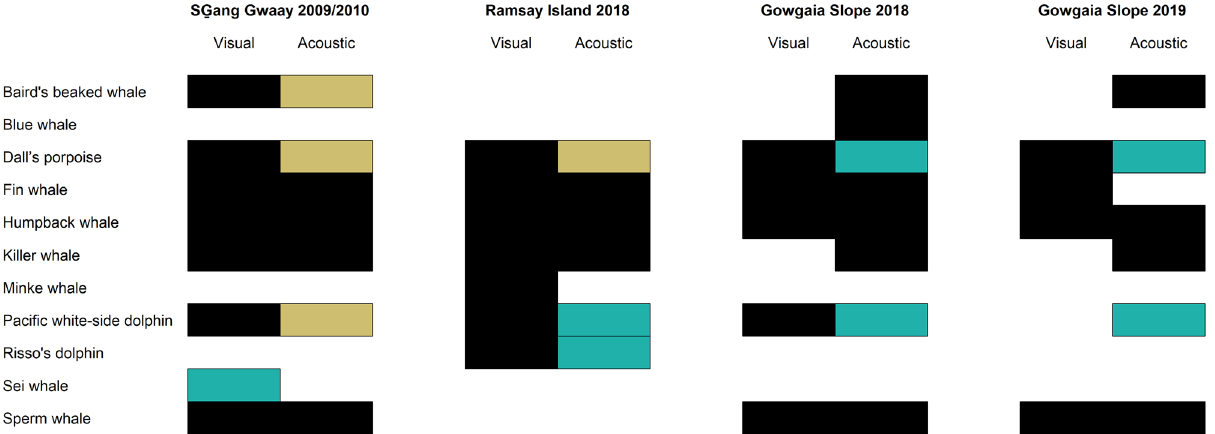
Figure 14. Summary of the visual sightings (black rectangle) from visual surveys (SG ̱ ang Gwaay: July/August 2009 and July 2010; Ramsay Island: August 2018; Gowgaia Slope July 2018 and July 2019) and cetacean acoustic presence (black rectangle) in the area of hydrophones over the same time periods. Light brown indicates that this species is outside recorder frequency range. Green indicates that the species was likely observed (e.g., sei whale) or cannot be acoustically distinguished to species (porpoise or delphinid groups). *At SG ̱ ang Gwaay, the 2009 recordings started in September, and 2010 recordings overlapped only three days of visual surveys